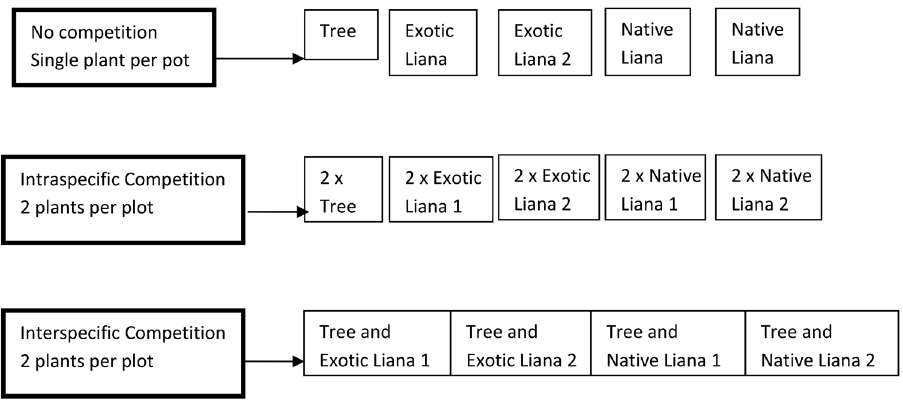
Figure 1. Experimental design showing set up of pot trials to measure maximum growth rate, intraspe- cific competition and interspecific competition of native and invasive lianas and a native host species. Seven replicates of each were grown in both medium and low light